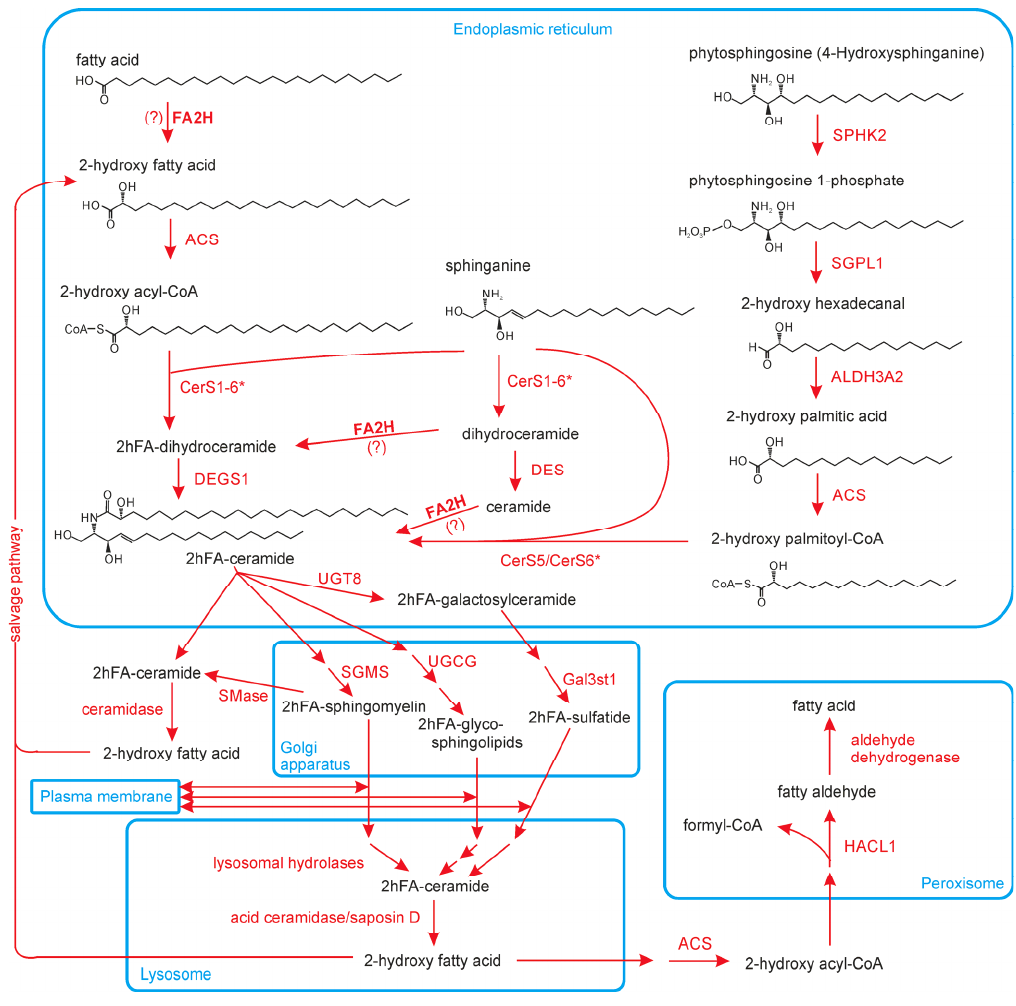
Figure 3. Overview of the metabolism of 2hFA-SL. As the physiological substrate(s) of FA2H is/are not yet clear, FA2H-dependent reactions are found here at different steps of the pathway, and the reactions are labeled with question marks (?) to indicate this fact. CerS1-6*/CerS5/CerS6*: In mammals, all six known ceramide synthases (CerS1 to CerS6) are capable of using 2-hFA-CoA as substrate. However, only CerS5 and CerS6 accept C16 acyl-CoA [63]. The FA2H-dependent reactions are shown with a C24 fatty acid/acyl residue; however, the enzyme apparently accepts acyl residues or fatty acids of various chain lengths. The α -oxidation of phytosphingosine can also metabolize longer sphingoid bases and thus generate longer 2hFA [61]. Note that many reactions, enzymes and metabolites, especially in the Golgi apparatus and lysosomes, are not specified in this Figure. Abbreviations/gene names and Enzyme Commission numbers: ACS—acyl-CoA synthetase (EC